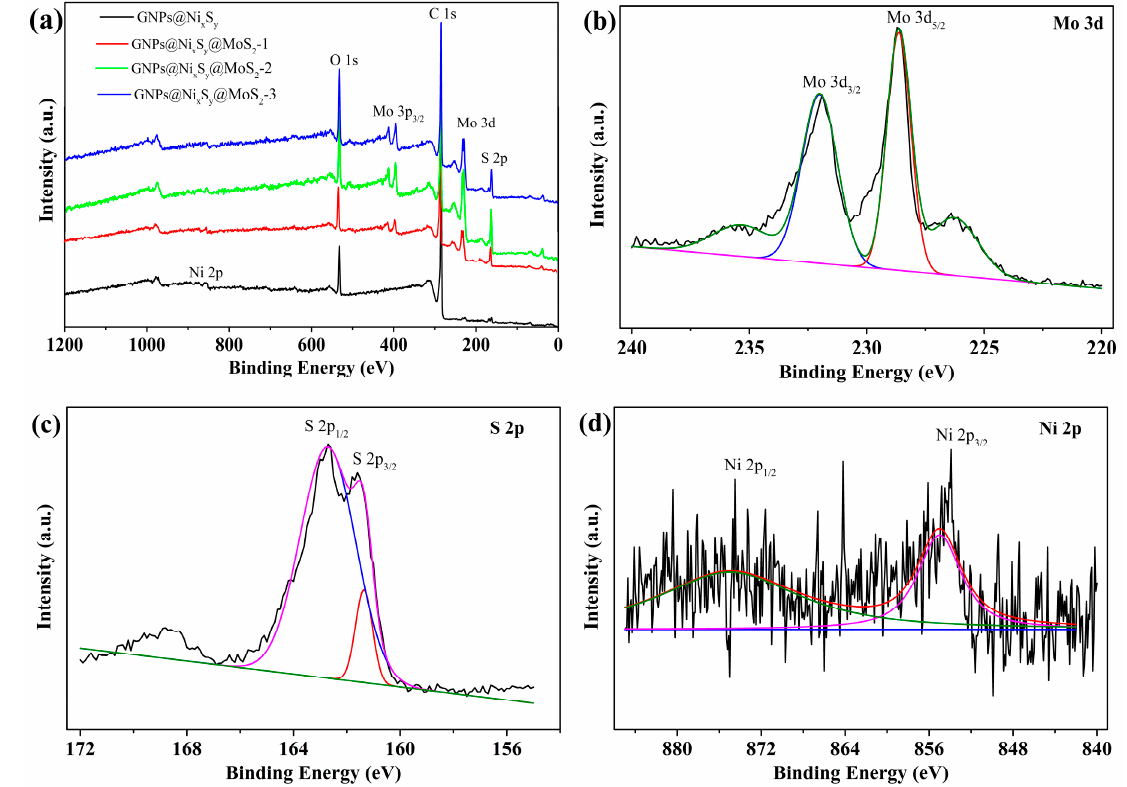
Figure 2. XPS survey spectrum ( a ) and core spectra of Mo 3d ( b ), S 2p ( c ), and Ni 2p ( d ) of